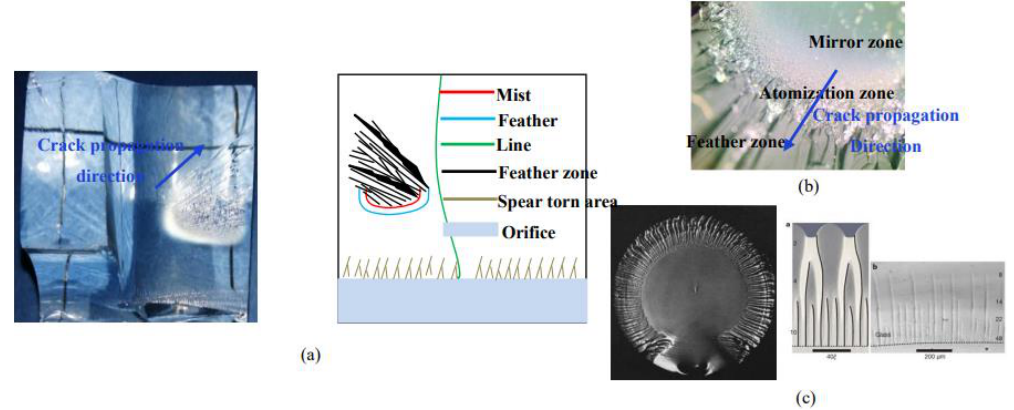
Figure 11. Surface features of remote crack. ( a ) Remote crack surface characteristics; ( b ) Dynamic fracture characteristics; ( c ) Spear torn Characteristics.